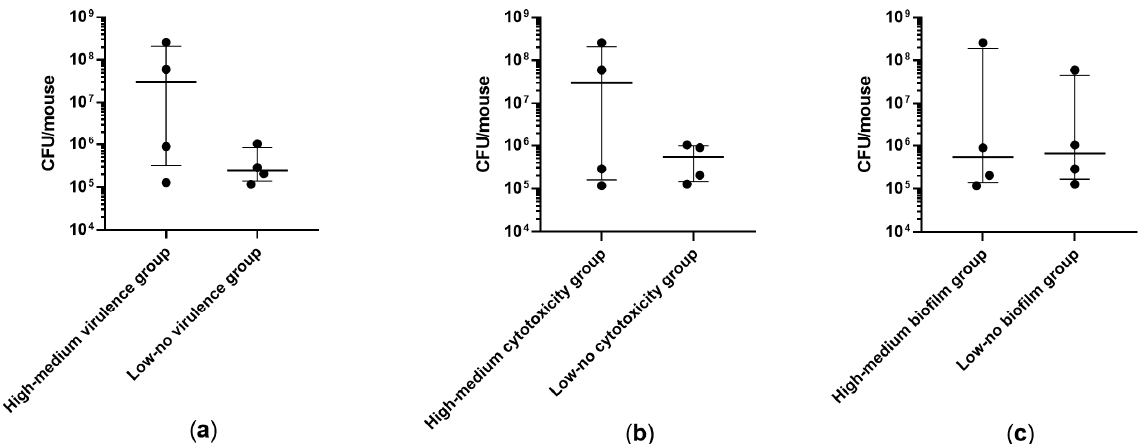
Figure 5. CFU recovered from WT mice lungs at 24 h after intratracheal challenge with clinical isolates showing ( a ) high–medium vs. low–no virulence in G. mellonella larvae, ( b ) high–medium vs. low–no cytotoxicity in human bronchial epithelial cells, ( c ) high–medium vs. low–no biofilm formation. Each value represents the mean of three animals challenged with each isolate. The median ± interquartile range of 12 mice per group is shown.